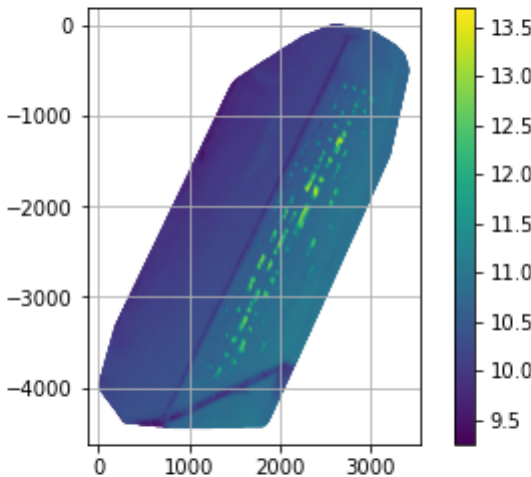
Figure 16. The result of the FANSCAN soil extraction applied to the ( bottom right ) DSM data in Figure 4 at N v = 100 fan rasters per horizontal seed point. Note how certain parts of the object field have been included in the soil extraction. The color scale is in meters and negative pixel numbers are an artifact of the image to matrix